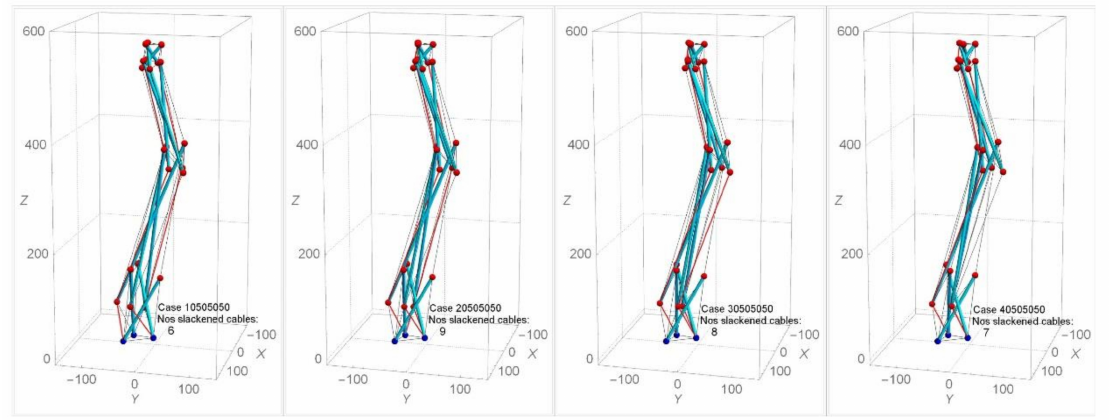
Figure 13. E ff ect of various twist angles for triangular cell at stage one on number of slackened cables in